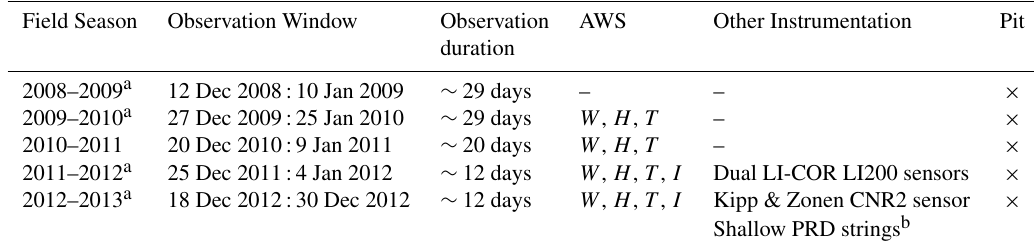
Table 1. Field observation table (see also Figs. 5–8). Field Season Observation Window Observation